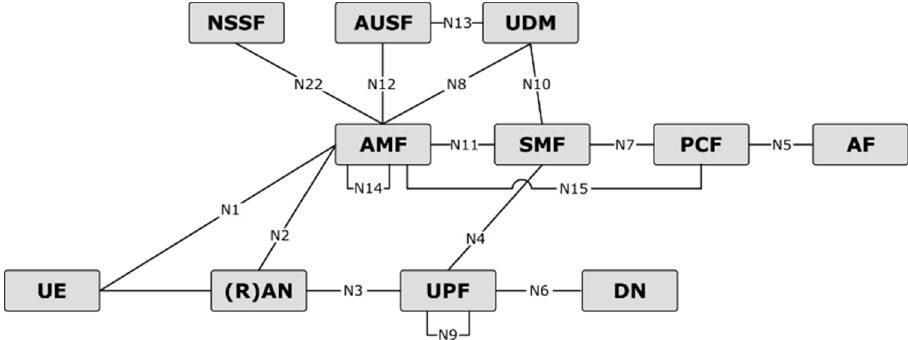
Figure 2. Reference point representation of the 5G system architecture [6].